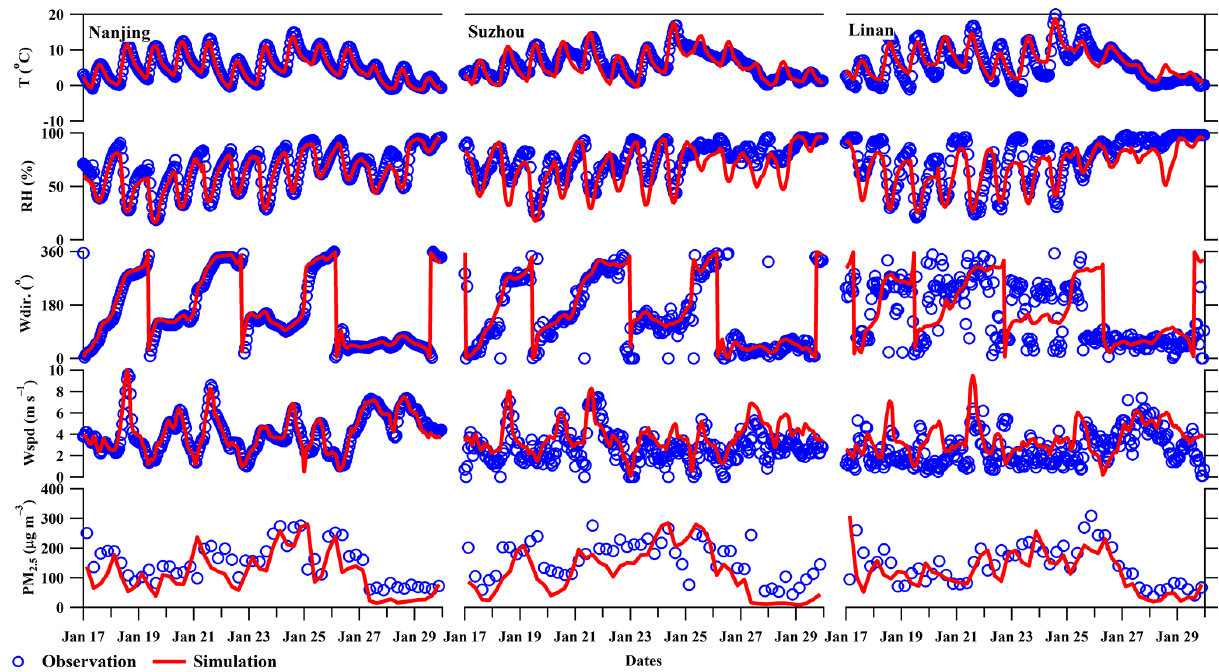
Figure 2. Observed and simulated 2m air temperature ( T ), relative humidity (RH), 10m wind direction (Wdir), wind speed (Wspd), and surface PM 2 . 5 concentrations from 00:00LT 19 January 2015 to 00:00LT 28 January 2015 at Nanjing, Suzhou, and Linan. Table 1. Statistical comparisons between the observed and simulated meteorological parameters and PM 2 . 5 concentrations at Nanjing, Suzhou, and Linan ∗ . Nanjing Suzhou